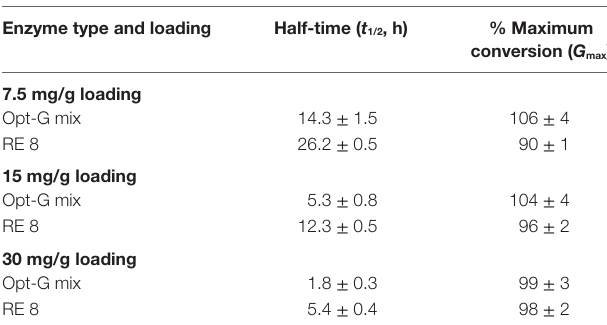
TaBle 1 | analysis of half times ( t 1/2 ) required to achieve 50% of maximum possible glucan conversion ( G max ) for optimal and non-optimal enzyme mixtures, shown in Figures 4–6.